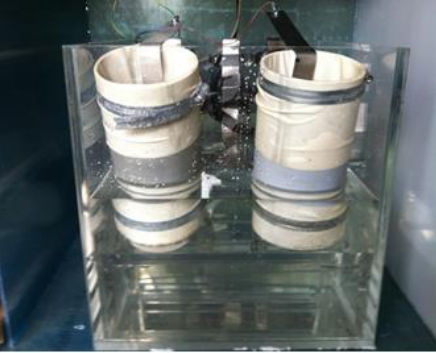
Figure 3. Chloride migration test set up.